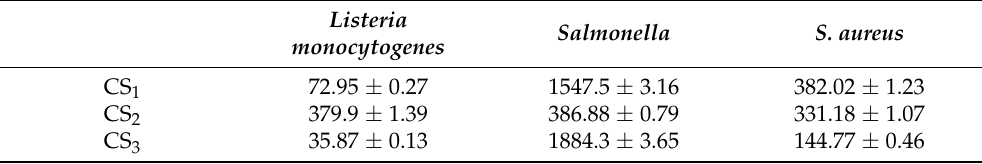
Data are mean of triplicate measurements ± SD. Different alphabetical letters in the columns indicate significant ( p < 0.05) differences between means in Tukey’s test.